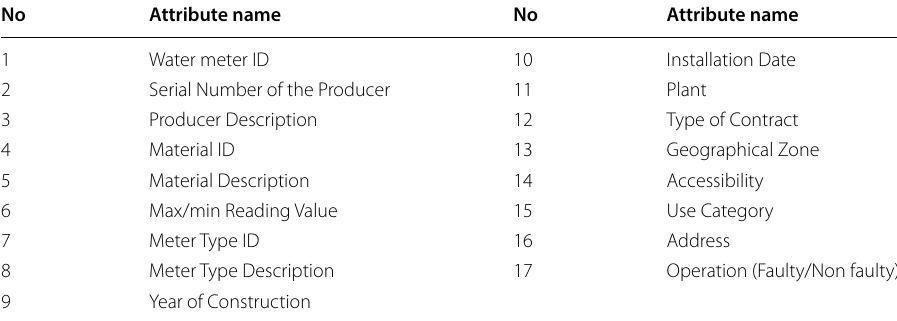
Table 2 Water meter dataset